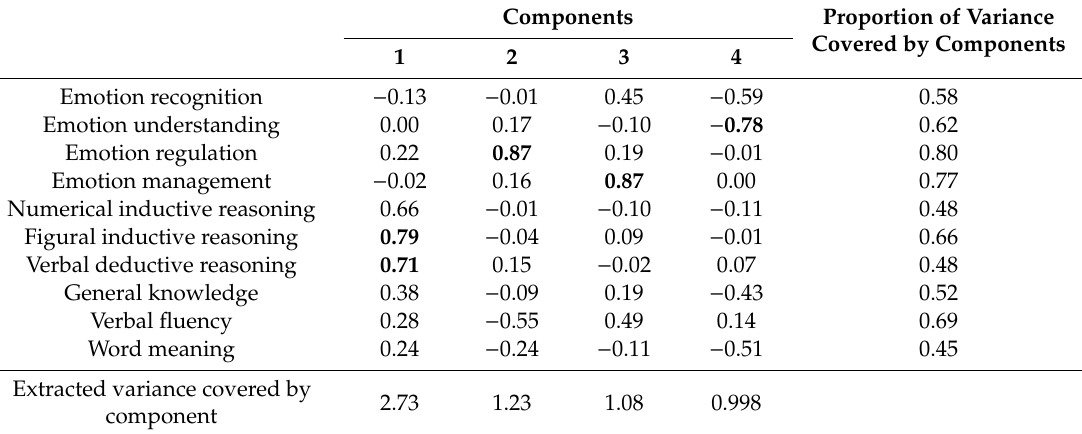
Table 2. Pattern matrix 1 and variances covered by components.